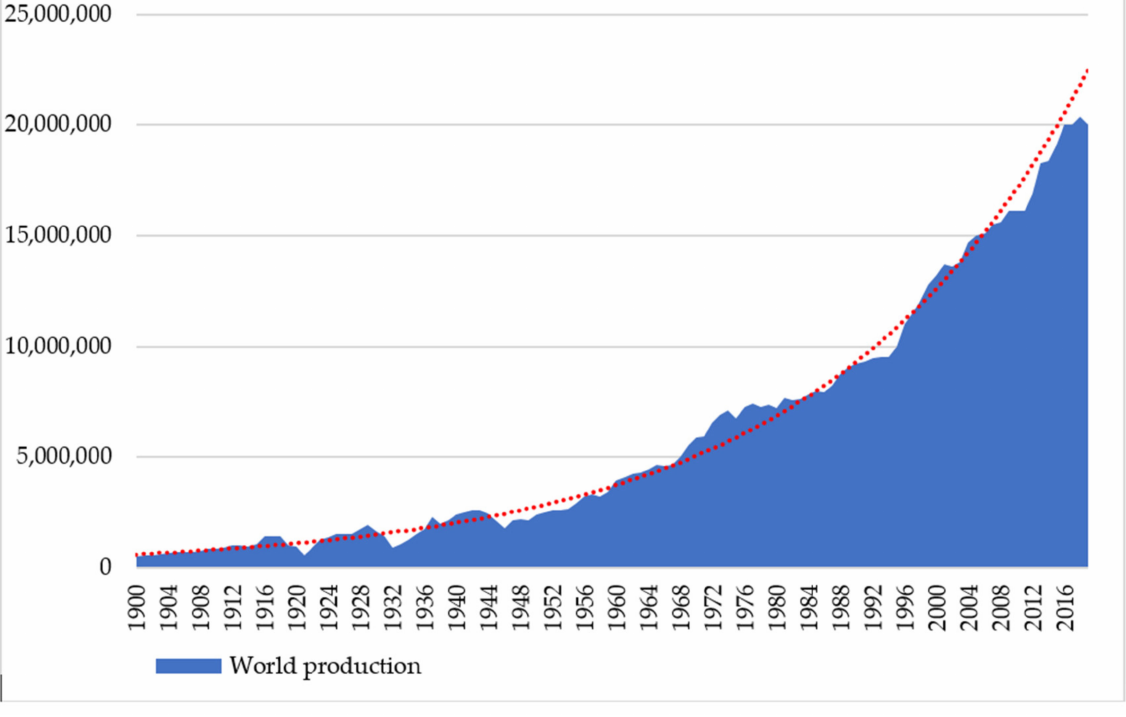
Figure A4. Global mine production of copper per thousand tons (build on the data from [25]), the red line is a